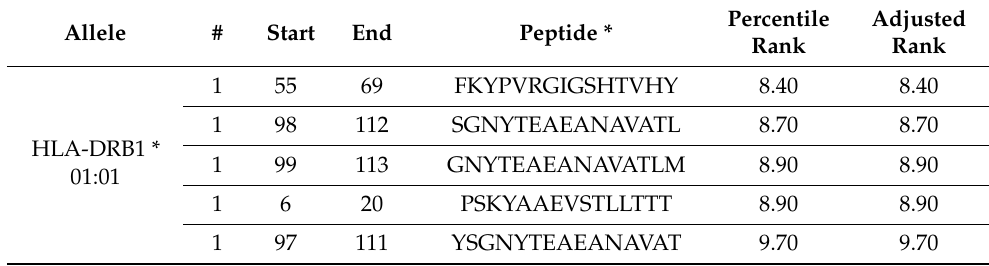
Table 2. MHC-II binding peptides (Consensus (comb.lib./smm/nn)) accessed on 17 March 2022.